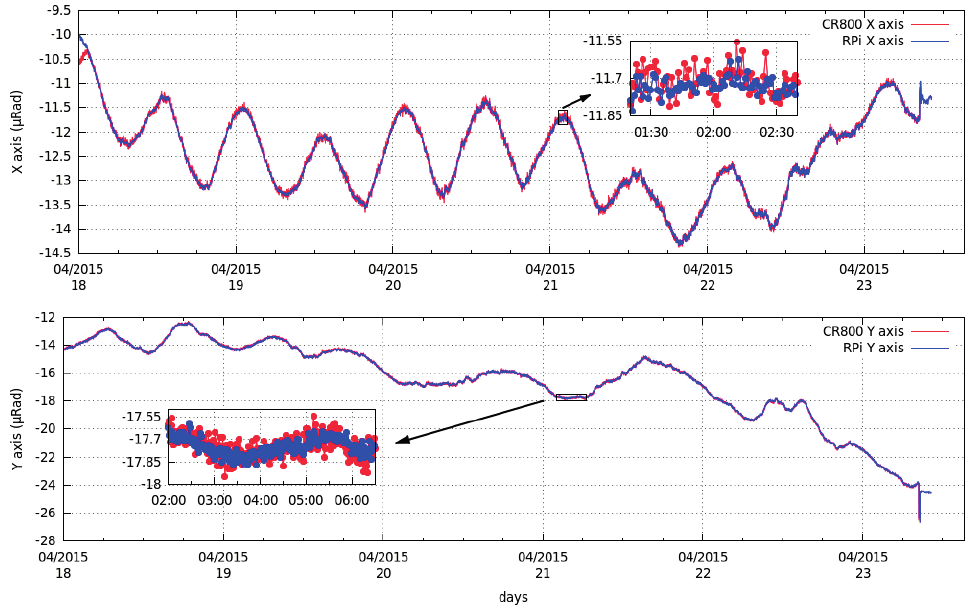
Figure 14. Comparison between a commercial system and the developed system. The upper picture depicts the evolution of the X-axis and a detail of the noise in both systems.